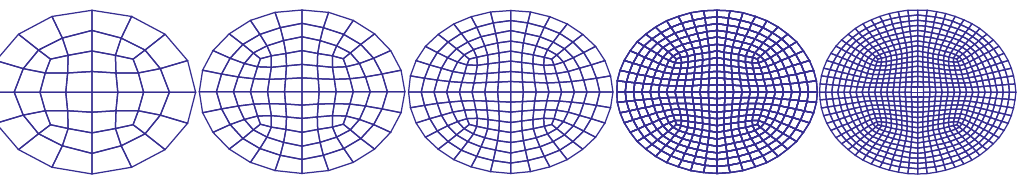
Figure 10: Meshes with different elements of a clamped circular plate divided for various FEMs; from left to right: 48, 108, 192, 432, and